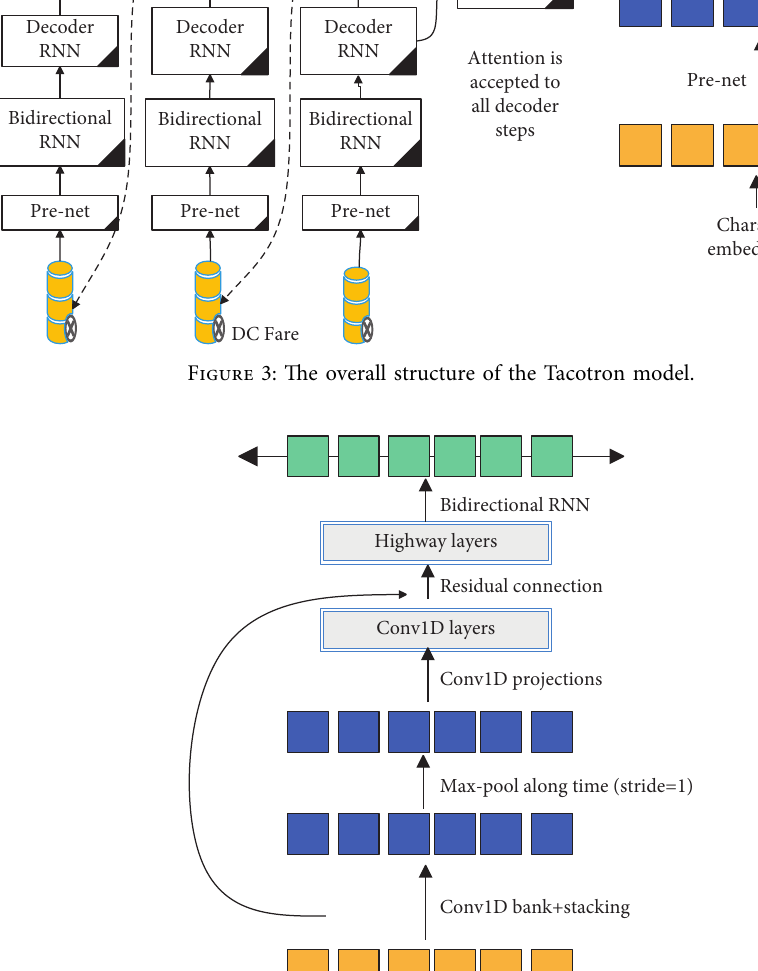
Figure 4: CBHG structure in Tacotron